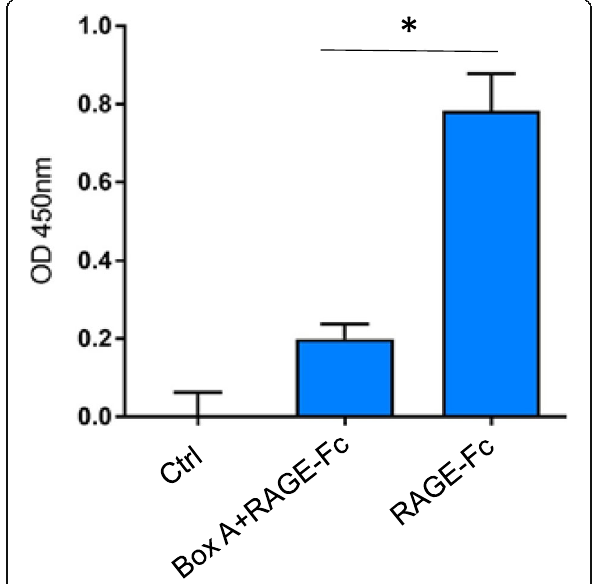
Fig. 4 ELISA demonstrating box A binding to RAGE. Soluble RAGE- Fc chimera (0.25 nM) was incubated with an excess amount of box A (10 μ M) at room temperature for 30 min. The mixture was then added to HMGB1 coated plate (60 nM) and incubated for 100 min at room temperature. After washing the plates, anti-human HRP antibody was added and incubated for 90 min at room